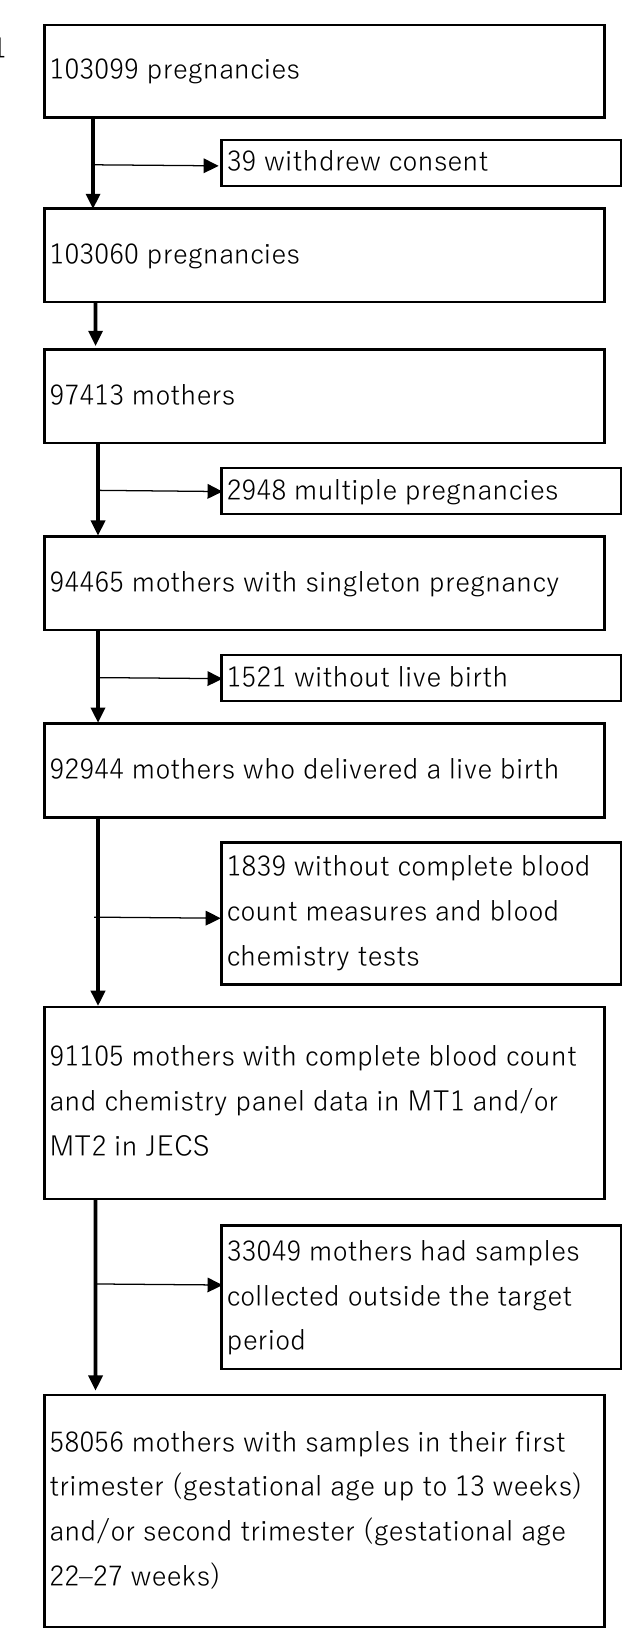
Figure 1. Flow chart of this study.